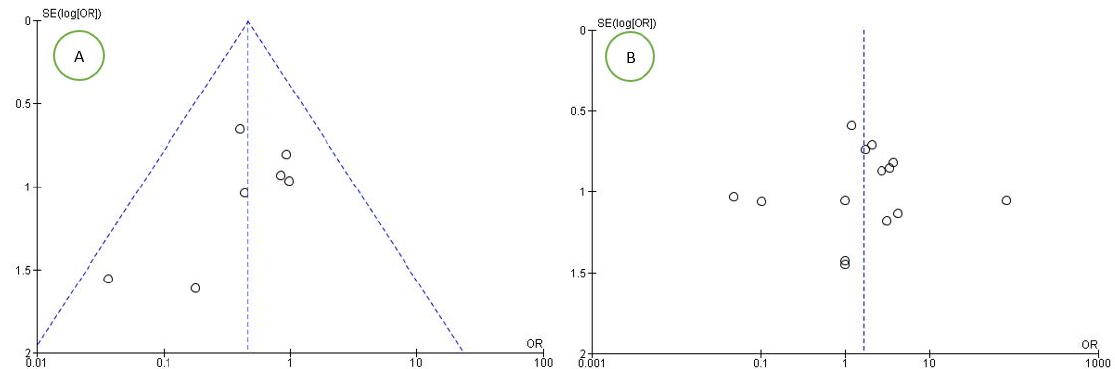
Figure 2. Funnel plots of the evaluation of heterogeneity for the ( A ) second and ( B ) third